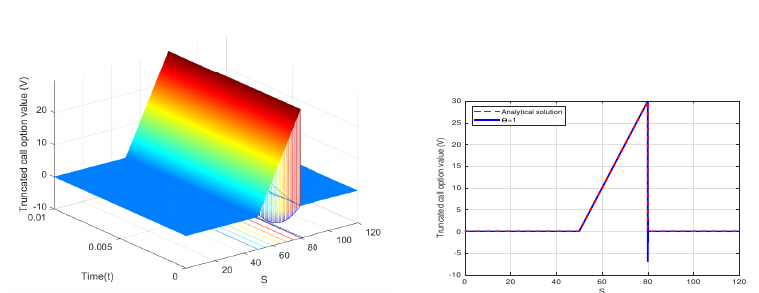
Figure 2. Spurious oscillations in the solution provided by the θ -method with ∆ S = 0.01, ∆ t = 10 − 4 , 1 and θ = 2. Parameter values: r = 0.07, σ = 0.001, T = 0.01, U = 80, K = 50, L = 20, S max = 120.